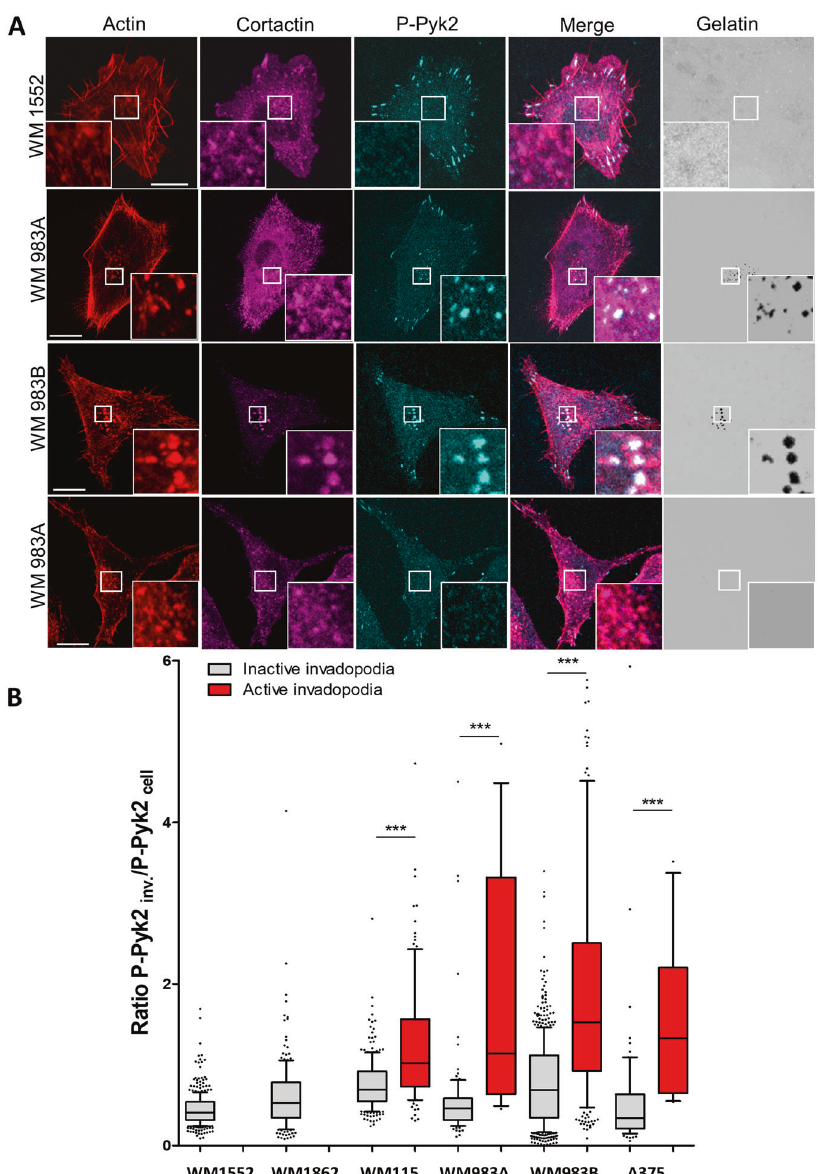
Fig. 3 P-Pyk2 localisation at invadopodia correlates with matrix degradation. A In situ and metastatic melanoma cells were plated on FITC- Gelatin (Grey), fi xed, and labelled for actin (Red) cortactin (Magenta) and P-Pyk2 (Cyan). Boxed regions and insets depict invadopodia (White) and degradation areas were identi fi ed as black holes on fl uorescent gelatin. Note the presence of P-Pyk2 at focal adhesions but also in a subset of invadopodia from metastatic melanoma cells. Note the presence of “ active invadopodia ” de fi ned as colocalisation of actin/cortactin spots with degradation areas whereas inactive invadopodia are de fi ned as actin/cortactin spots without underneath degradation. Scale bar: 10 µm. B Histograms represents mean and whiskers with 10 – 90 percentile of the ratio P-Pyk2 signal at invadopodia over P-Pyk2 signal in the whole cell calculated for each active (0 – 256, in red) and inactive invadopodia (79 – 569, in grey) from at least 10 cells per cell type from 3 independent experiments; *** P < 0.001; ANOVA followed by Tukey ’ s Multiple Comparison for active versus inactive assembly and further show that cortactin and/or Pyk2 are suitable with actin dots at invadopodia (Supplemental Fig. 2A). Similarly, in for invadopodia-focal adhesion interplay investigations. A375 cells expressing vinculin-mCherry, vinculin colocalised with actin and cortactin at focal adhesions but not at invadopodia Loss of Cortactin at invadopodia is time-correlated to the (Supplemental Fig. 2B). On the other hand, both Pyk2 and formation of focal adhesion-containing cortactin during cortactin localised to a subset of focal adhesions and invadopodia migration in invasive melanoma expressing either Pyk2-GFP or cortactin- Next, using time-lapse imaging of live A375 cells expressing dsRed. Indeed, in these cells, Pyk2-GFP localised to peripheral cortactin-dsRed plated on fl uorescent gelatin, we found that focal adhesions and to some invadopodia identi fi ed by dot-like cortactin localisation at invadopodia occurs several minutes actin/cortactin colocalisation (Supplemental Fig. 3A) whereas before gelatin degradation (Fig. 4 and Video 1) in agreement cortactin-dsRed localised to some focal adhesions and to with previous studies [33]. The increase in cortactin level reached a invadopodia (Supplemental Fig. 3B). This result suggests a peak about 200-230 min after the beginning of the invadopodia dynamic recruitment of Pyk2 at speci fi c stages of invadopodia